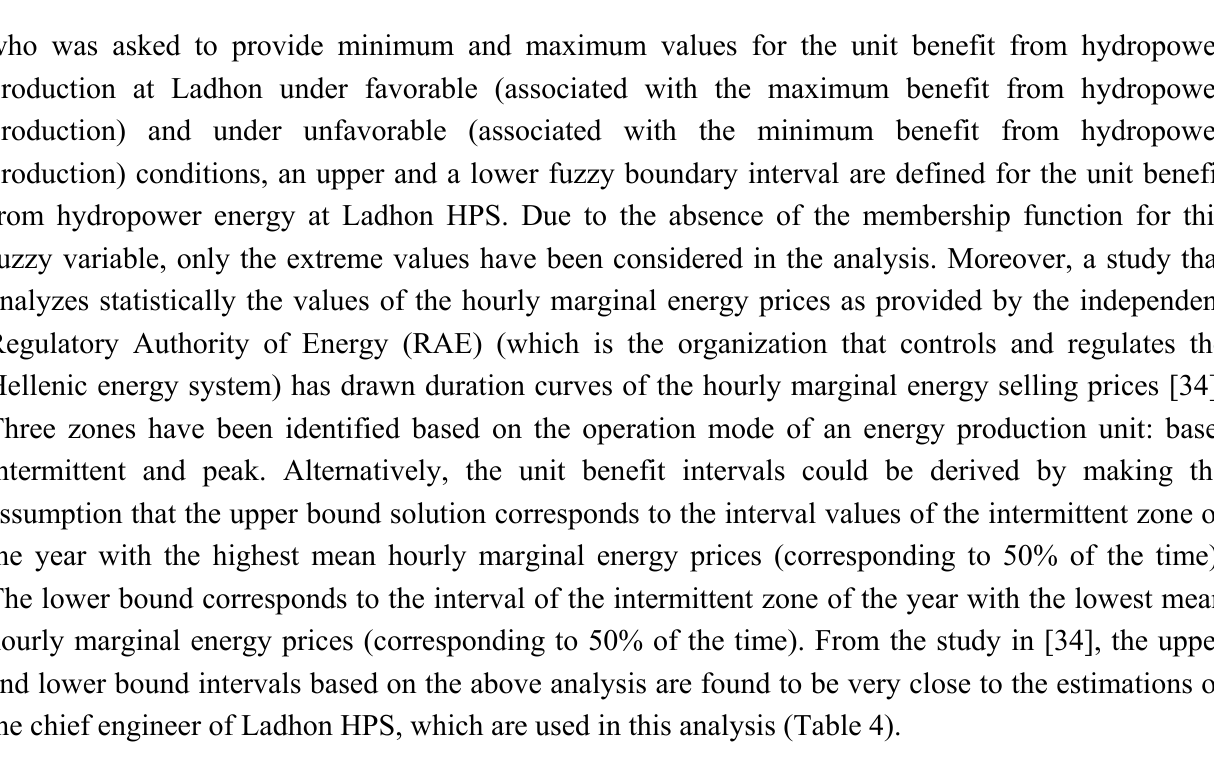
Table 4. Lower and upper fuzzy boundary for the unit benefit (NBHPLadhon and NBHPFlokas) and unit penalty (CHPLadhon and CHPFlokas) for hydropower production at Ladhon and at